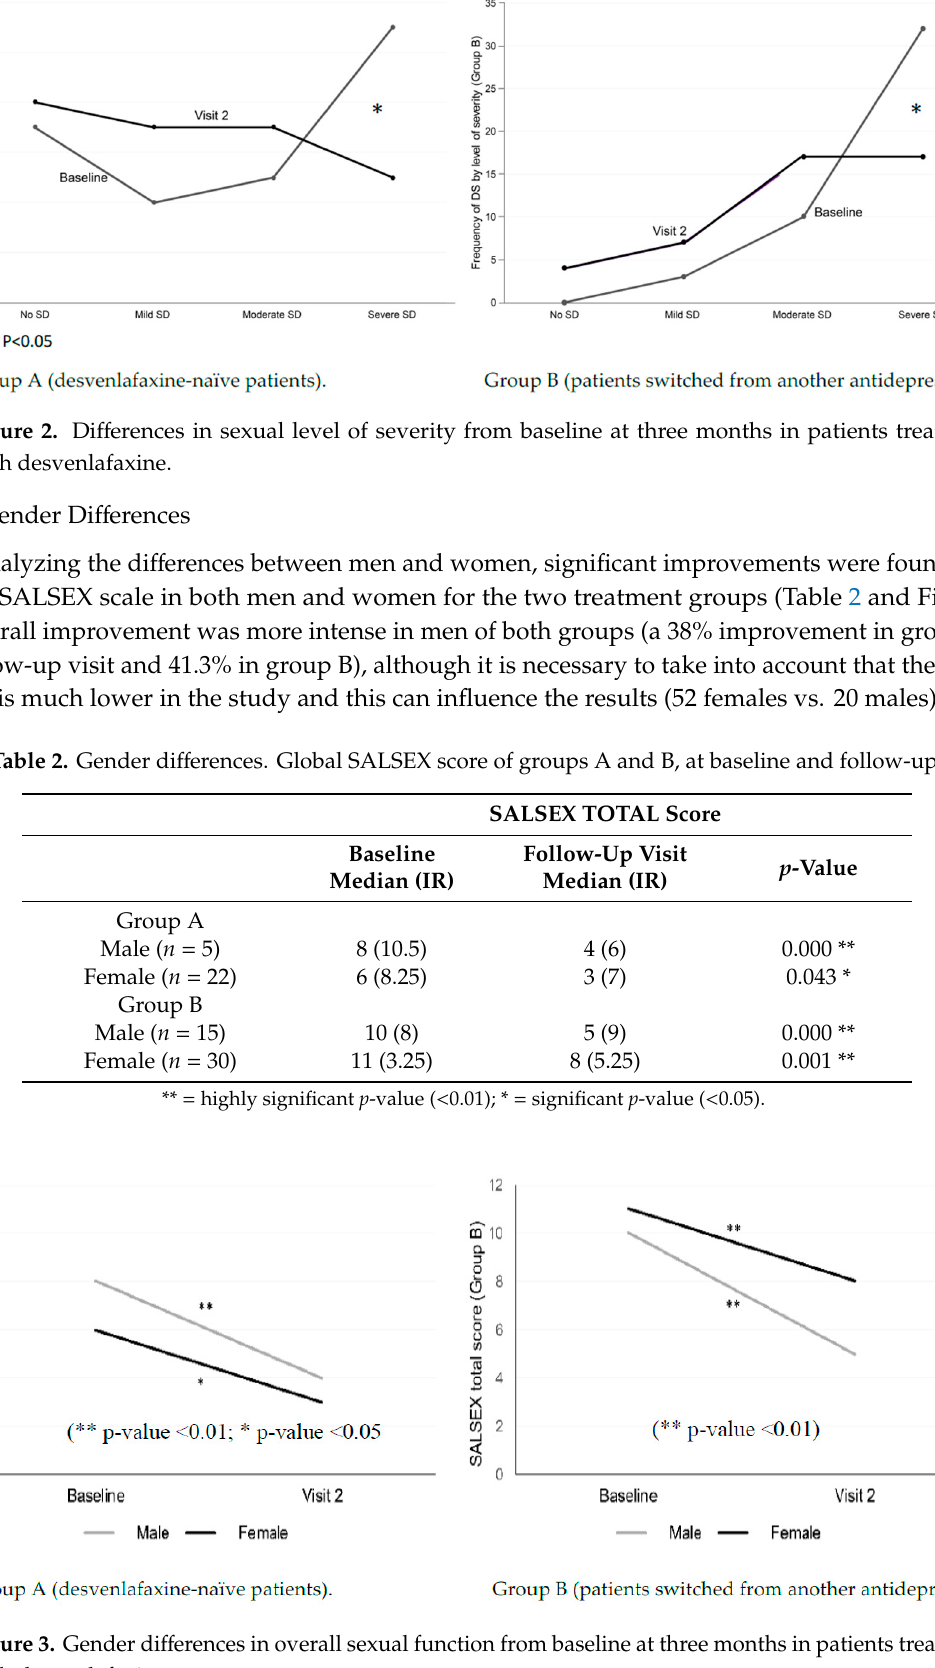
Figure 3. Gender di ff erences in overall sexual function from baseline at three months in patients treated Figure 3. Gender differences in overall sexual function from baseline at three months in patients with treated with desvenlafaxine.